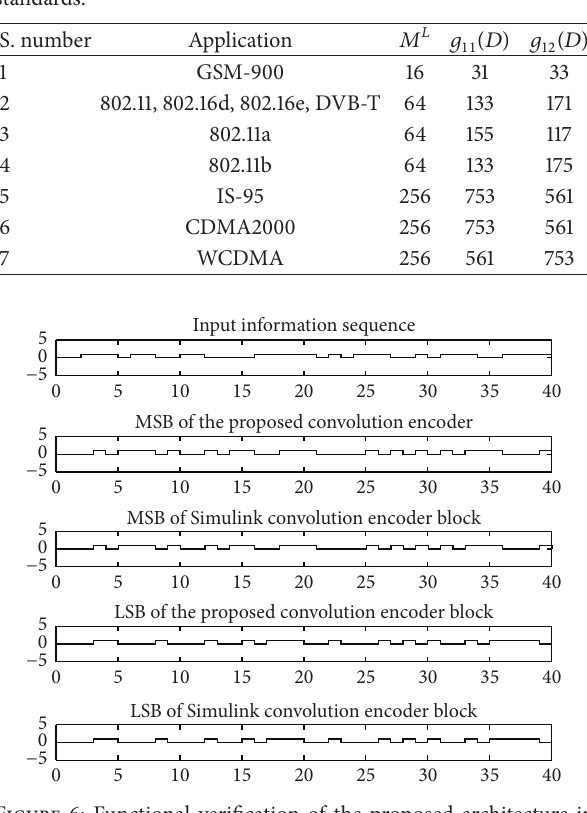
Figure 6: Functional verification of the proposed architecture in MATLAB Simulink.